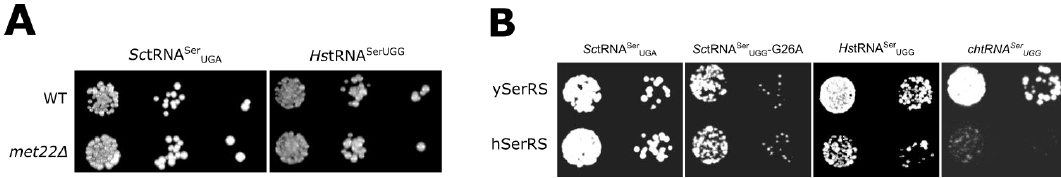
Figure 3. Evaluating mechanisms of decreased function of human tRNA SerUGG in yeast. ( A ) BY4742 ( MET22 ) and CY7641 ( met22Δ ) containing either wild-type (WT) Sc tRNA SerUGA or Hs tRNA SerUGG were grown to stationary phase in media lacking uracil before cells were spotted in 10-fold serial dilutions onto a plate lacking uracil and grown at 30°. ( B ) Expression of human SerRS, SARS, increases the functionality and thus the toxicity of HstRNA SerUGG and ch tRNA SerUGG in yeast. Yeast strain BY4742 containing a URA3 centromeric plasmid expressing Sc tRNA SerUGA , Sc tRNA SerUGG -G26A. Hs tRNA SerUGG or ch tRNA SerUGG and the LEU2 multicopy plasmid YCplac181 containing myc-tagged yeast SES1 (ySerRS) or human SARS (hSerRS) were grown to stationary phase in media lacking uracil and leucine. Cell densities were normalized, and cultures were spotted in 10-fold serial dilutions on the same media.